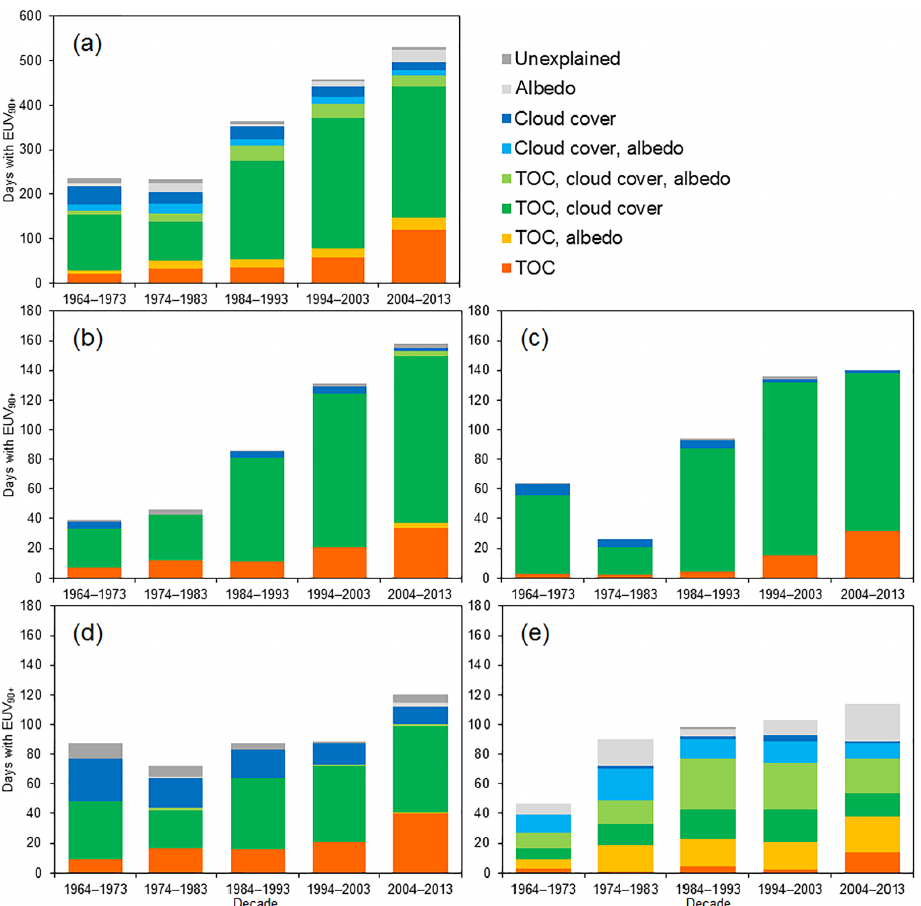
Figure 4. The number of days with EUV 90 + in the individual studied decades, and their explanation by TOC, cloud cover, albedo, and their combinations, for (a) the entire year, (b) spring, (c) summer, (d) autumn, and (e)